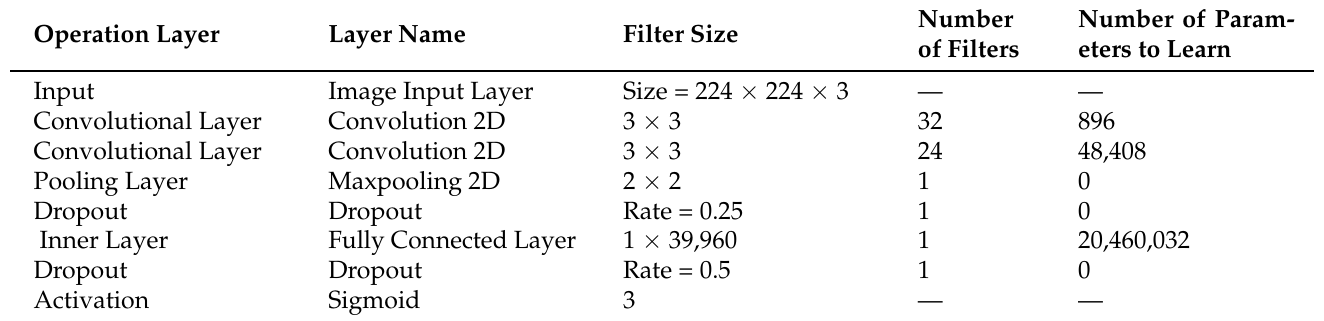
Table 3. The proposed networks for depth classification